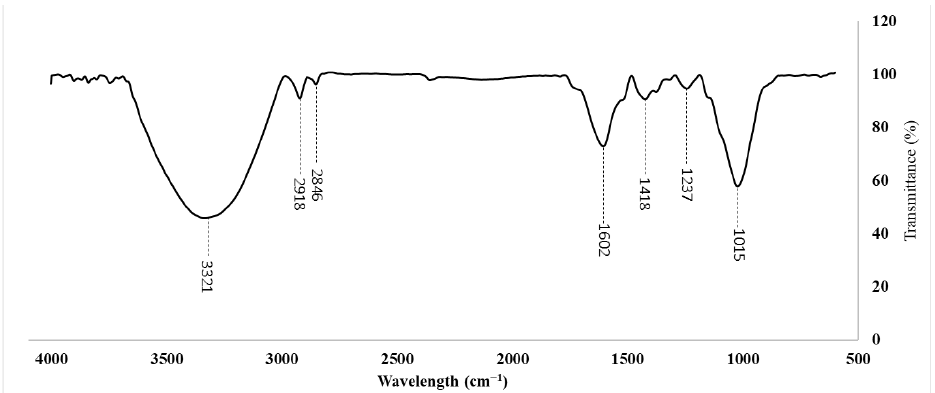
Figure 14. FTIR spectra of the insulation composite material.